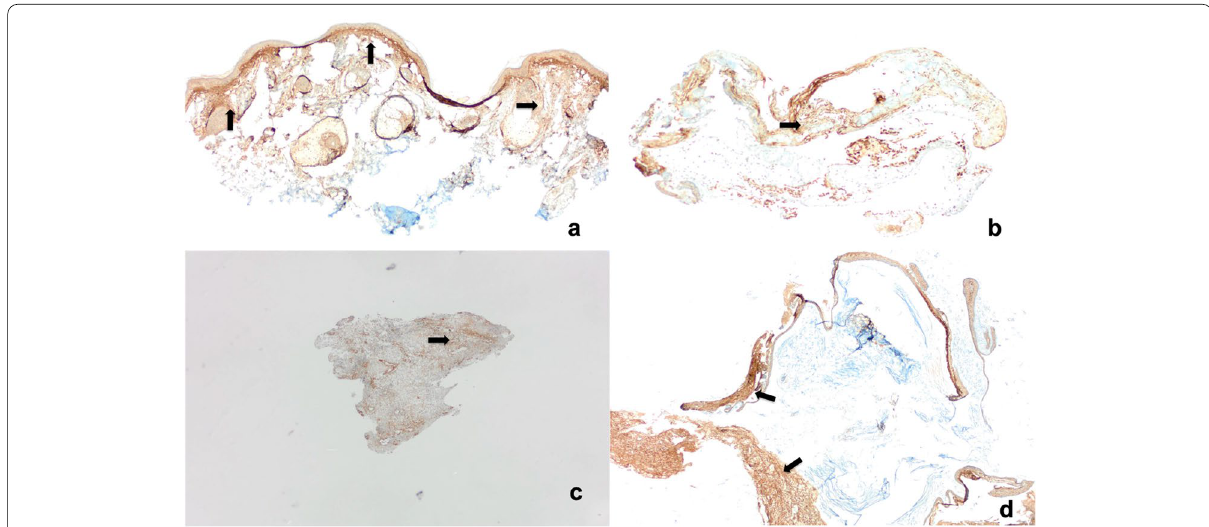
Fig. 1 a Outer ear canal skin (Periostin IHK x40): epithelial staining score score, stroma . c Granulation tissue (Periostin IHK x40): no epithelial staining score, stroma + epithelial staining score